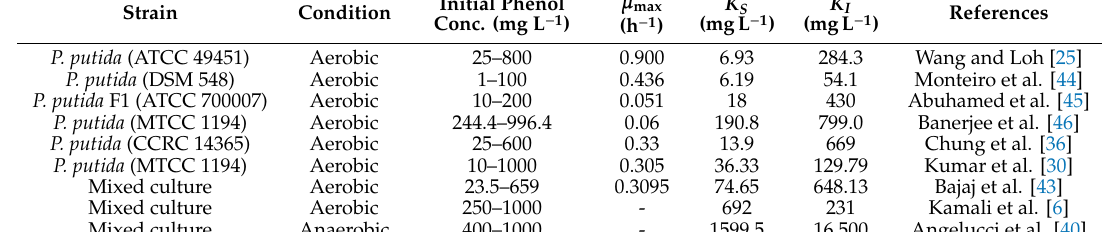
Figure 8. Specific growth rate of cells varied with various initial phenol concentrations. Haldane kinetics was fitted to the experimental data using the least-squares methodology. Maximum specific growth rate ( μ max ) is 0.31 h −1 , phenol half-saturation constant is 26.2 mg/L, and the phenol inhibition constant is 255.0 mg/L. Table 2. Biokinetic parameters of Haldane kinetics for phenol biodegradation. Strain